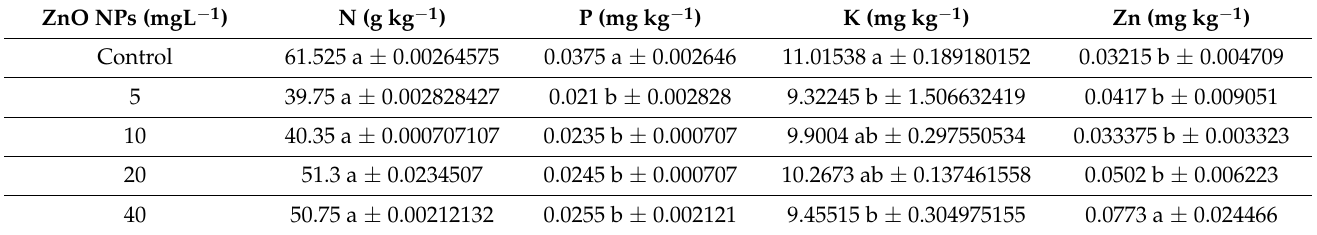
Table 4. Zinc oxide nanoparticles (ZnO NPs) impact the composition of Nitrogen (N) (g kg − 1 ), Phosphorus (P) (mg kg − 1 ), Potassium (K) (mg kg − 1 ), and Zinc (Zn) (mg kg − 1 ) in C. longa leaves. Mean values followed by the same letter within a column are not significantly different at p = 0.05, as measured by Duncan’s